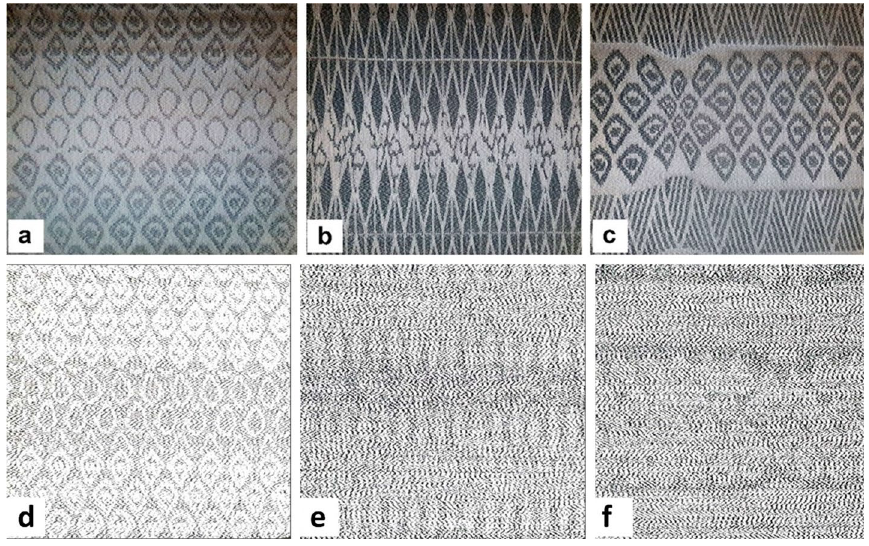
Fig. 7 Images taken during the day: a RF 1, b RF 2 and c RF 3. Images taken in a dark room: d RF 1, e RF 2 and f RF 3. RF Reflective fabric